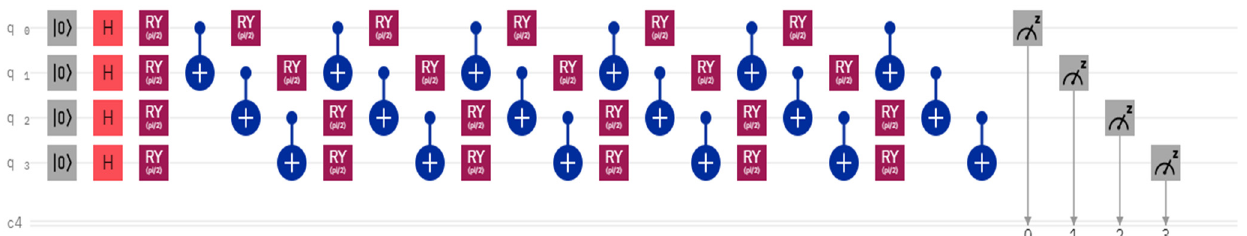
Figure 2. Quantum variational circuit. H symbol denote Hadamard gate, RY symbol denote rotational Y gate, + symbol denote CNOT gate. z symbol denotes measurement stage.